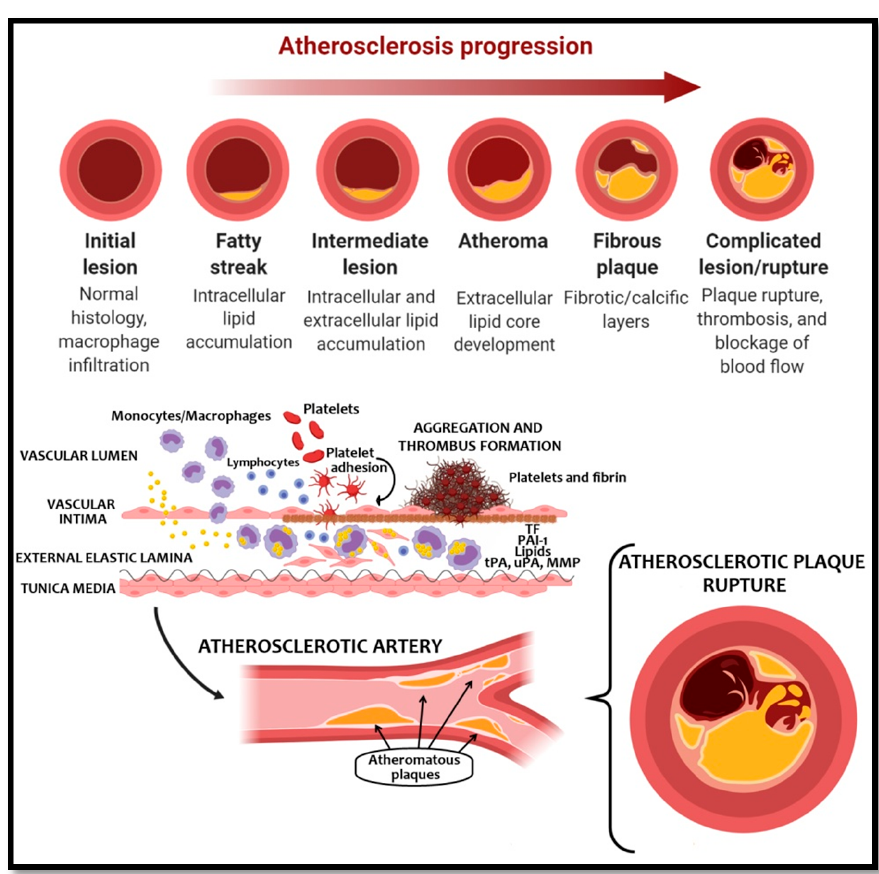
Figure 1. Atherosclerosis progression, thrombus formation, and atherosclerotic plaque rupture. The main initiator of clot formation is the tissue factor (TF), which is released by endothelial cells after a vascular damage (for example, in the case of a ruptured or ulcerated atherosclerotic plaque) [26]. Indeed, elevated levels of TF have been shown in patients with PAD [27]. TF gains access to proconvertin (factor VII in plasma), and together form the TF/FVIIa complex. The TF/FVIIa complex activates small amounts of FIX and FX. On TF-exposing cells, FXa associates with FVa to form the prothrombinase complex. In the prothrombinase complex, prothrombin is converted into thrombin (factor IIa), which then transforms fibrinogen into fibrin [28–30].